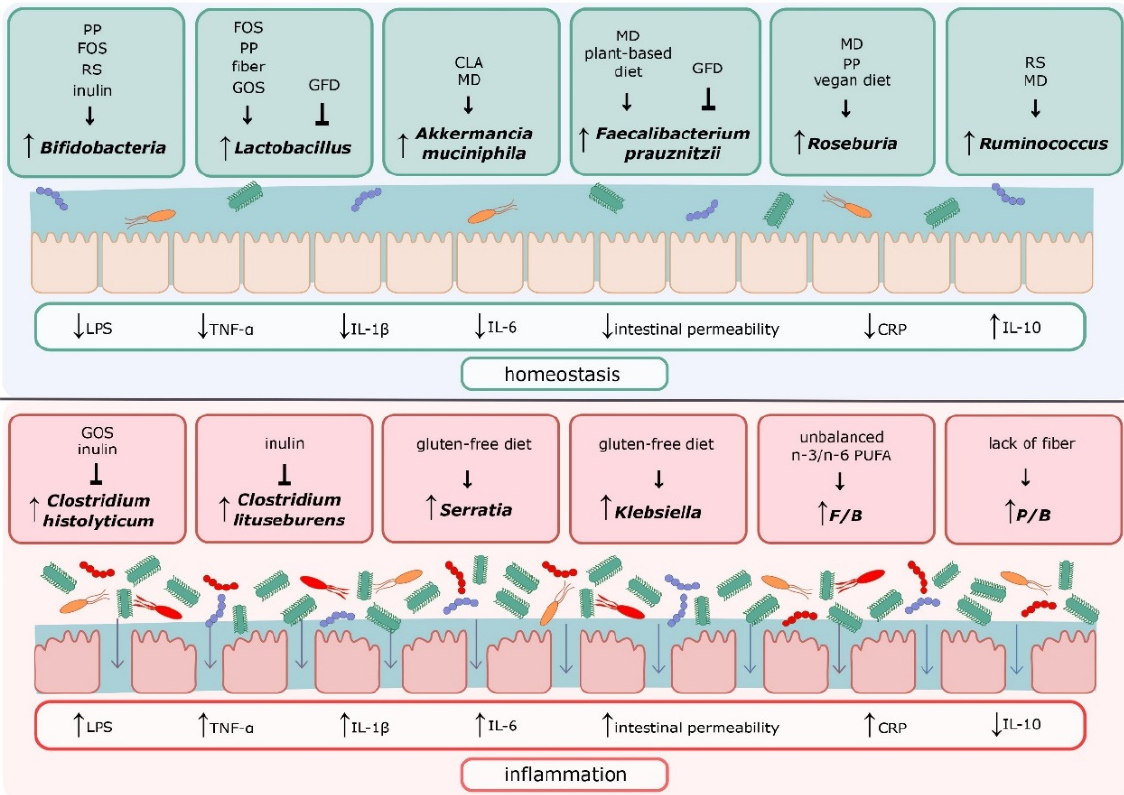
Figure 3. Effect of nutritional interventions on specific bacteria. Abbreviations: PP—polyphenols; FOS—fructooligosaccharides; RS—resistant starch; GOS—galactooligosaccharides; GFD—gluten-free diet; CLA—conjugated linoleic acid; MD— Mediterranean diet; LPS—lipopolysaccharide; TNF- α —tumor necrosis factor α ; IL-1ß—interleukin 1ß; IL-6—interleukin 6; CRP—C-reactive protein; IL-10—interleukin